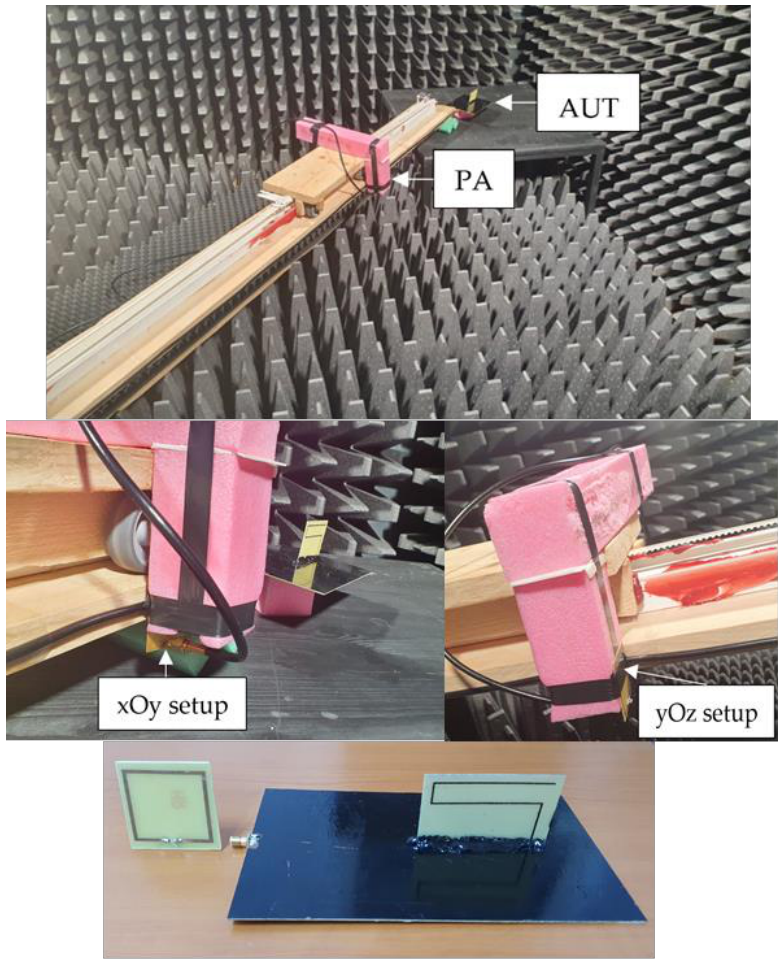
Figure 27. Measuring setup: mobile platform, xOy setup, yOz setup and antenna system details. Prior to evaluating the radiation originating from the common mode currents, the loop antenna used as a PA was first characterized in terms of effective area by using a two-identical antenna method [23] (Figure 28).